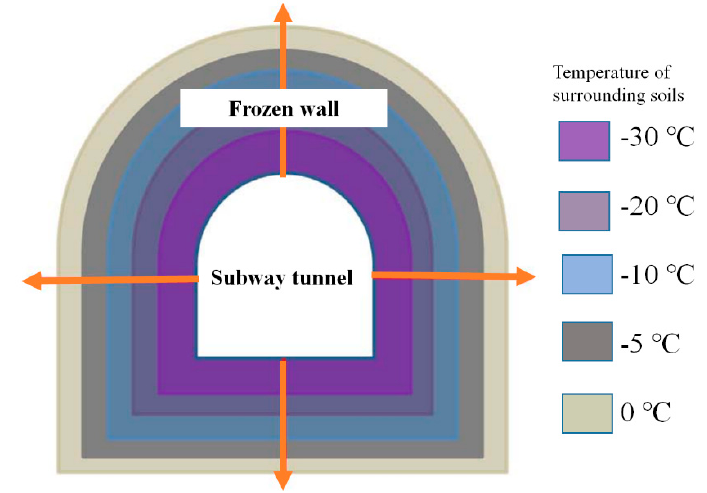
Figure 2. The mechanism of the artificial ground freezing circumstance in tunnel constructions.